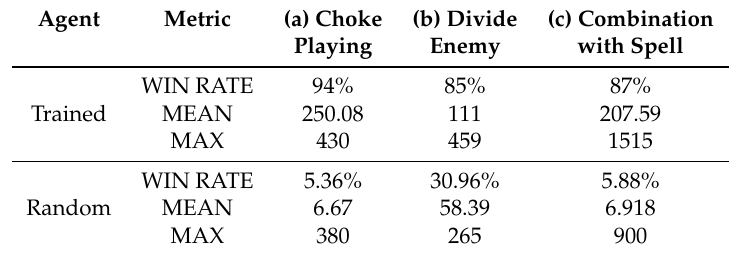
Table 2. Aggregated results for trained agent and random agent on